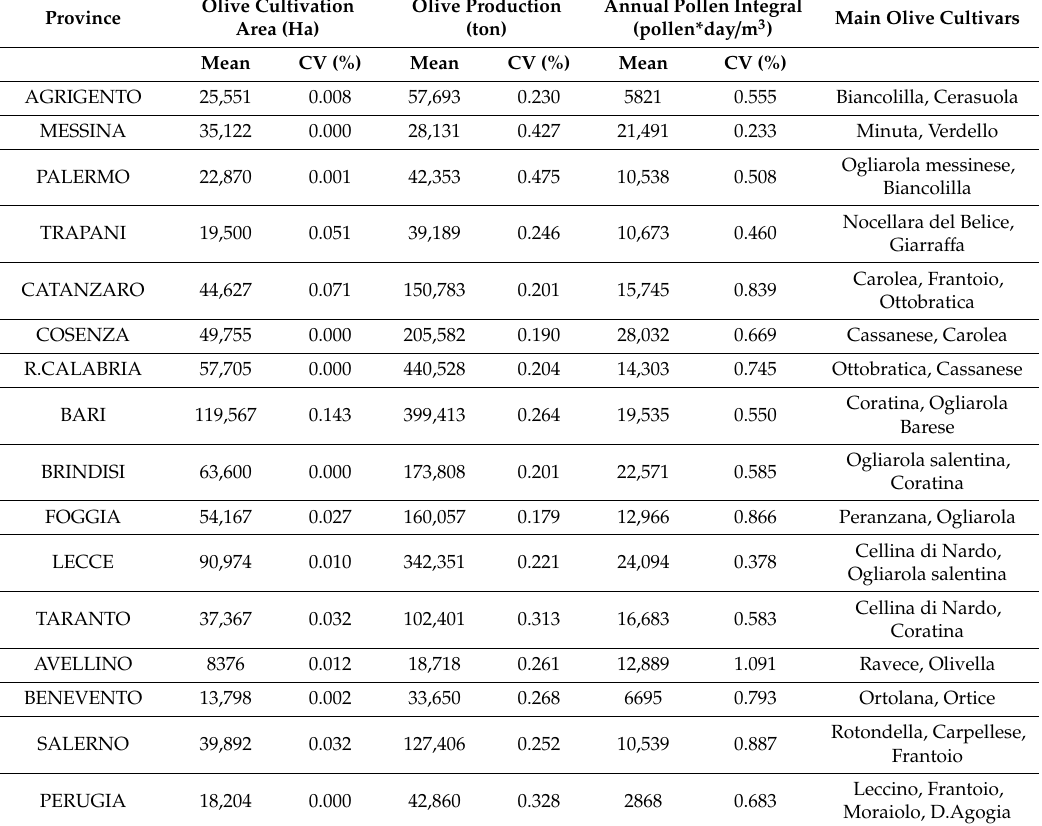
Table 1. Provinces, mean olive cultivation area, olive fruit production, and Annual Pollen Integral (APIn) for the period of 1999–2012. Olive surface data are only available for 2007